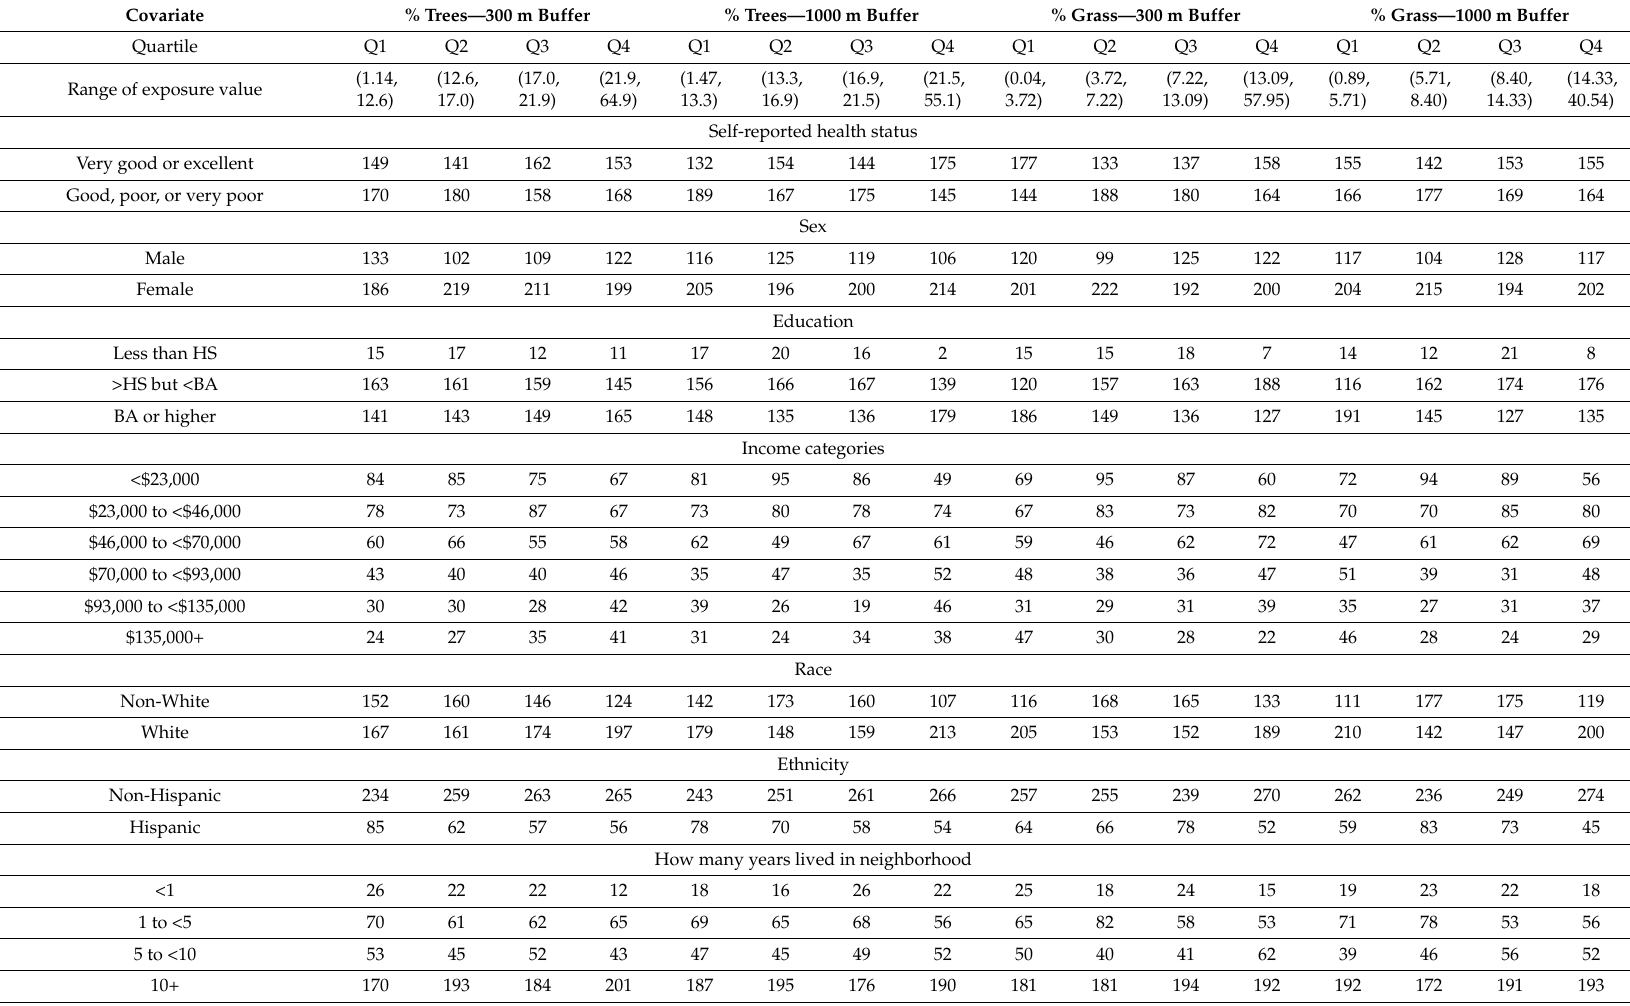
Table 2. Covariate distribution (n) from N = 1281 across quartiles (Q) of greenspace. Covariate % Trees—300 m